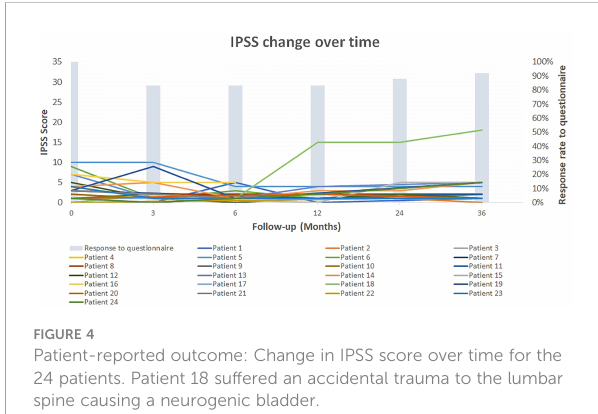
FIGURE 4 Patient-reported outcome: Change in IPSS score over time for the 24 patients. Patient 18 suffered an accidental trauma to the lumbar spine causing a neurogenic